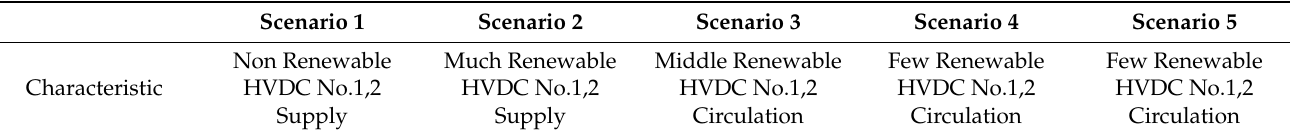
Table 6. Scenario A configuration (HVDC No.3 non-modeling).